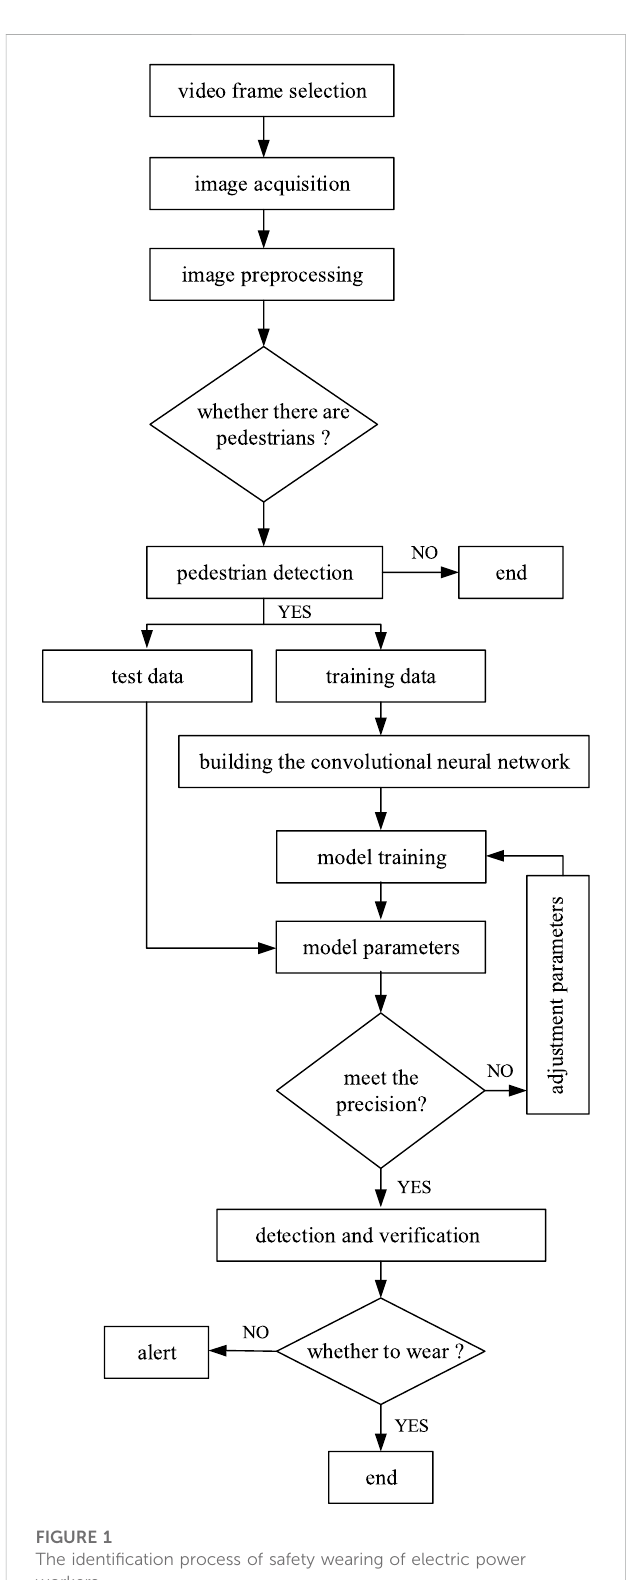
FIGURE 1 The identi fi cation process of safety wearing of electric power